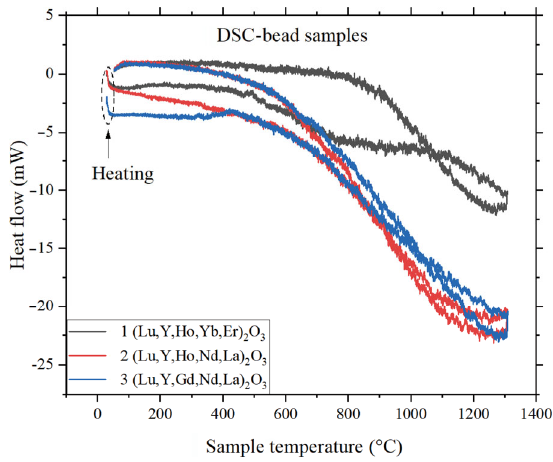
Fig. 5 DSC curves were measured on the as-prepared bead samples in air. The temperature range is 30–1300 ℃ , and the heating and cooling rate is 5 ℃ /min.